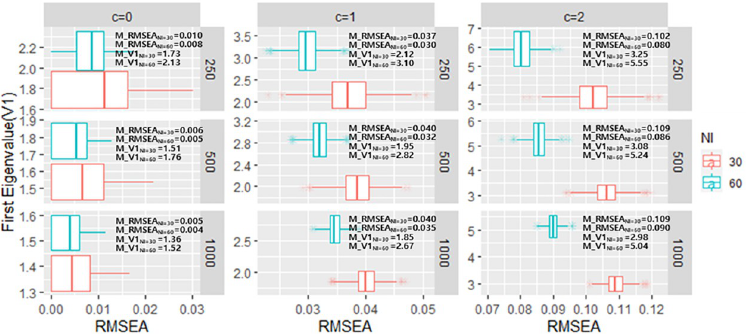
Fig 5. The relationship between first eigenvalue of PCAR and RMSEA in each TD simulation conditions. ( Note . M: mean of values across simulations).